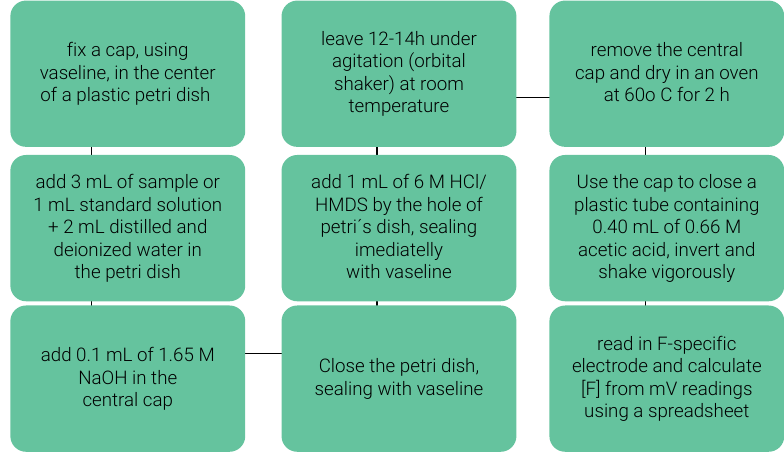
Figure 2. F determination using microdiffusion facilitated by